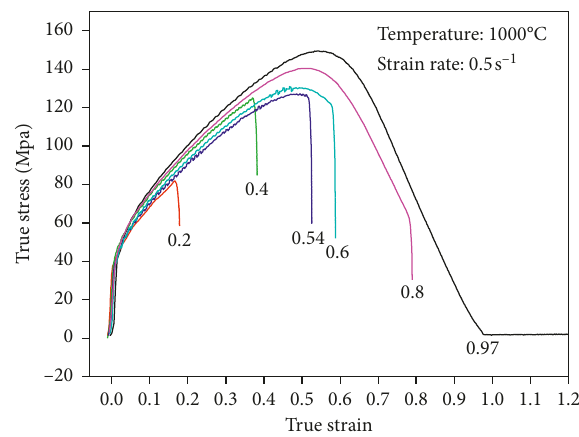
Figure 6: The true stress-strain curve at high